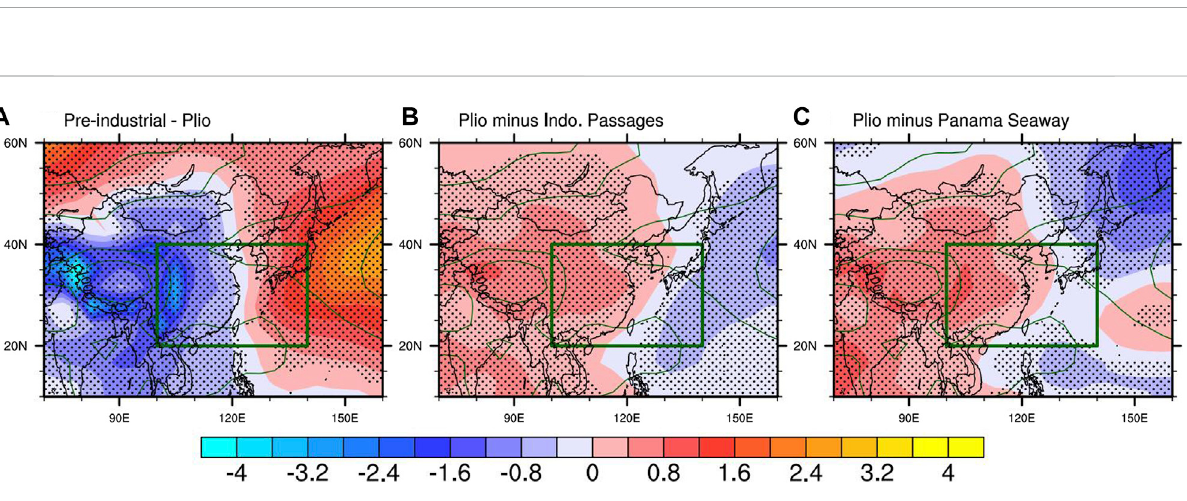
FIGURE 5 Responses(shading)ofJJAmeansealevelpressureto (A) decreasingCO 2 , (B) theconstrictionoftheIndonesianPassagesand (C) theclosureof the Panama Seaway. Contours depict the JJA mean SLP for Plio. Green boxes indicate the range of EASM (20 ° N – 40 ° N, 100 ° E – 140 °